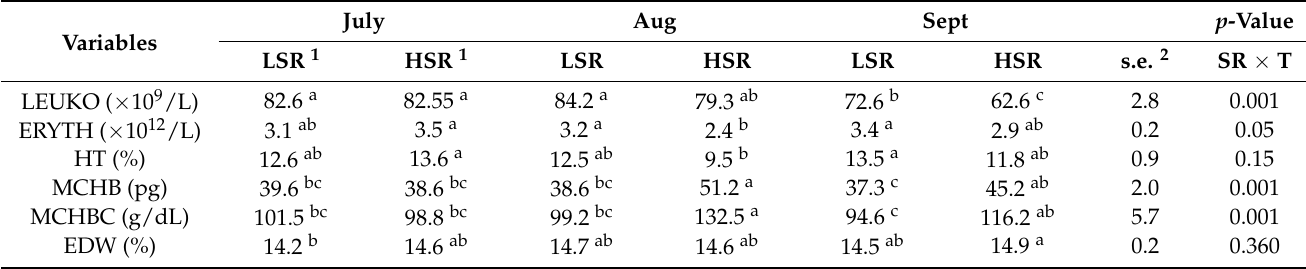
Table 7. Least square means ± standard error for the interaction of social rank (i.e., LSR and HSR) by time (i.e., 3 dates) for the plasmatic components, leucocytes (LEUKO), erythrocytes (ERYTH), hema- tocrit (HT), mean corpuscular hemoglobin (MCHB), mean corpuscular hemoglobin concentration (MCHBC), and erythrocyte distribution width (EDW) in Dorper rams ( n = 24) in northern Mexico (25 ◦ N) 1,2